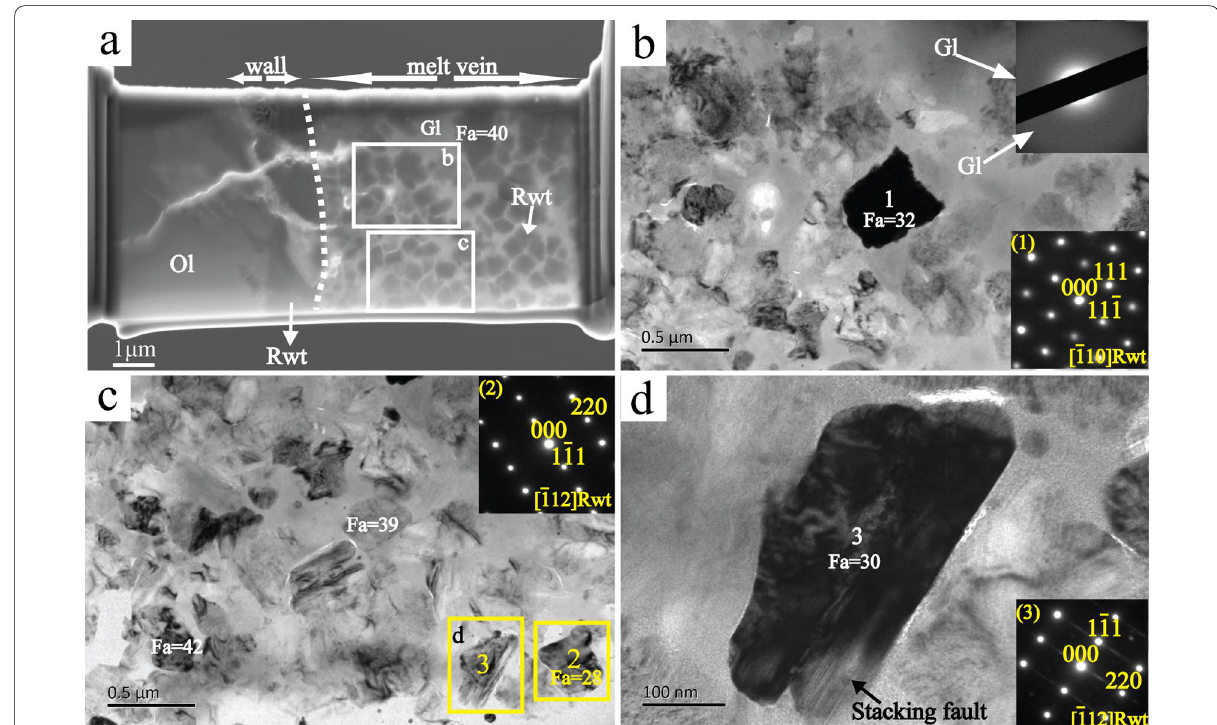
Fig. 8 BF-TEM images of FIB-slice #3 of the ringwoodite microlite clusters. a SE image of FIB-TEM-slice #3. b , c Enlarged BF-TEM images of the yellow rectangle “b” and “c” in a . BF-TEM image and SAED pattern indicate that the ringwoodite grains are distributed in glass matrix. d Enlarged BF-TEM image of the yellow rectangle “d” in c . SAED pattern of grain 3 shows that the ringwoodite has one set of weak stacking fault on